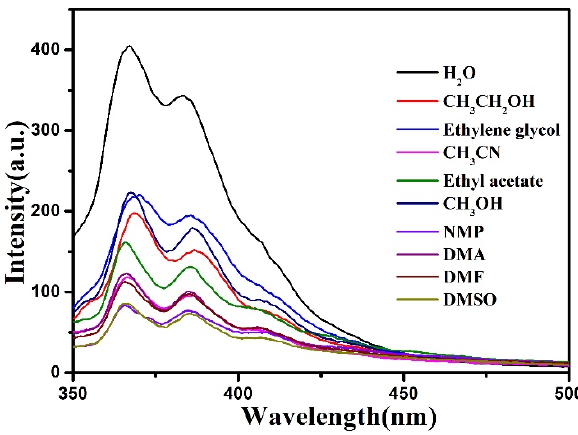
Figure 4. Fluorescence spectra of the compound in different solvents.